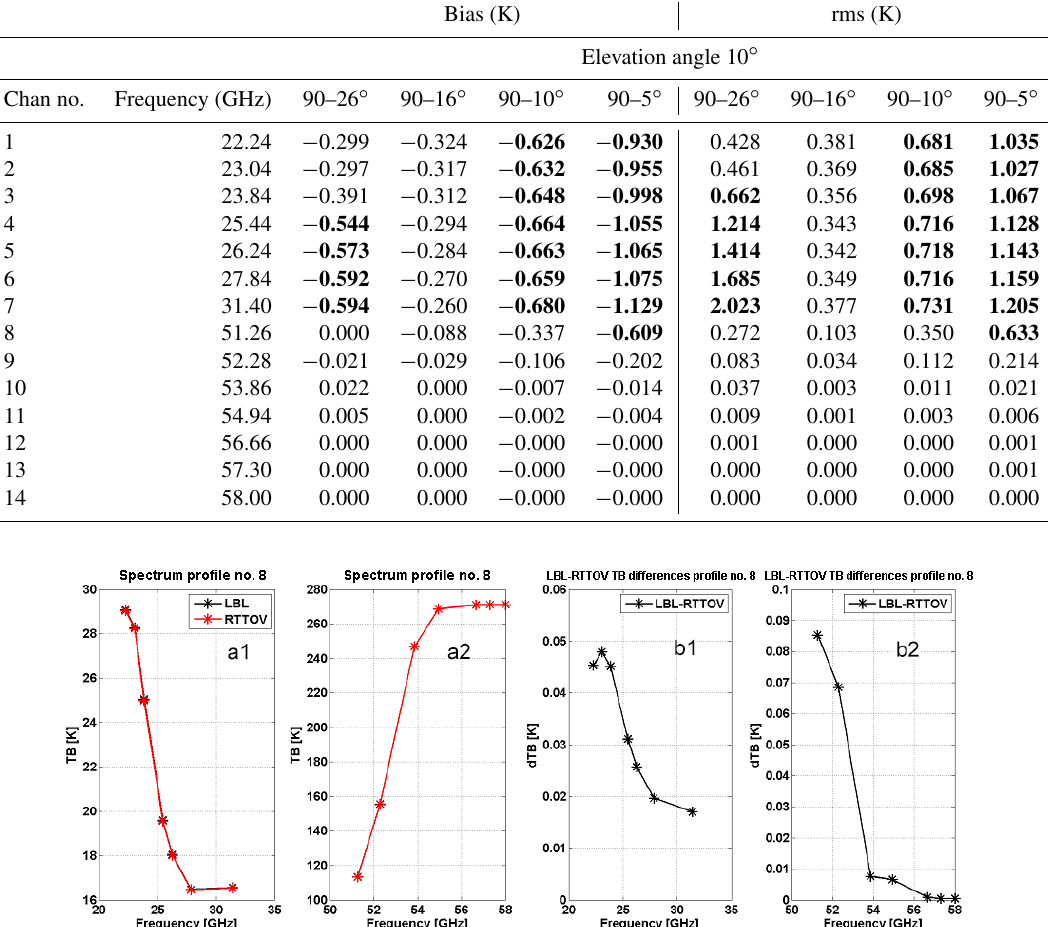
Figure 2. (a1) TB at K-band channels (20–35GHz) computed by RTTOV-gb (red stars) and LBL R98 (black stars) from profile no. 8 of the dependent set. (a2) Same as (a1) , but for V-band channels (50–60GHz). (b1) TB differences (R98 minus RTTOV-gb) at K-band channels. (b2) Same as (b1) , but for V-band